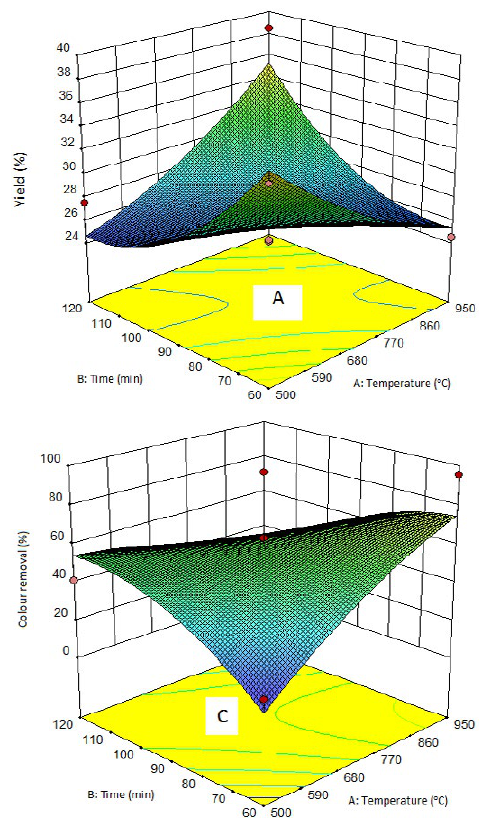
Fig. 6: 3D Plot of (A) biochar yield (%), (B) COD removal (%) and (C) Colour removal (%)